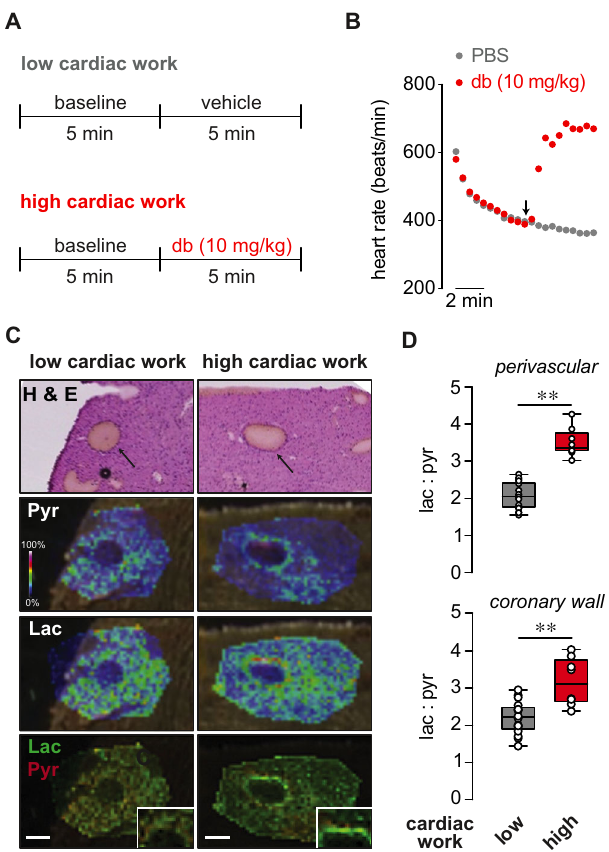
Fig. 1 Increased myocardial workload promotes local elevation of lactate:pyruvate ratio in the coronary arterial wall. A Schematic showing protocol for induction of acute cardiac stress prior to collection of tissues for MALDI-MS imaging. To induce high cardiac work, anesthetized mice with stable heart rates of 400 – 450 bpm were treated with dobutamine (db; 10 mg/kg, i.p.). Heart rate was continuously monitored, and hearts were rapidly cryopreserved in the thoracic cavity and excised after 2 – 3 min of stabilized heart rate responses to either db or PBS (vehicle). B Symbol plot showing exemplary heart rates recorded every 30 s before (i.e., during induction and stabilization of anesthesia) and after administration of either db (10 mg/kg; i.p.) or PBS. C Images of left ventricular intramyocardial coronary arteries in H & E-stained heart sections and corresponding intensity-coded MALDI-MS images showing lactate (Lac) and pyruvate (Pyr) relative to background signals in hearts from low and high cardiac work mice. x – y resolution: ~20 μ m. Insets show magni fi ed region of interest at coronary arterial wall. Scale bars represent 200 μ m. Experiment was repeated twice with similar results. D Box and whiskers plots (line: median, box: 25th to 75th percentile, whiskers: min and max) showing lactate:pyruvate ratios in perivascular myocardium (region of interest within ~250 μ m from coronary wall; top ) and coronary wall ( bottom ) in hearts of low and high cardiac work mice. (low cardiac work: n = 16 technical replicates, 4 mice, high cardiac work group: n = 8 technical replicates, 2 mice), perivascular, ** p < 0.0001, coronary, ** p = 0.0003 (unpaired two-sided t test). Source data are provided as a Source Data fi